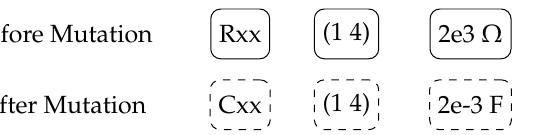
Figure 4. A more serious circuit mutation where the type of the element changes